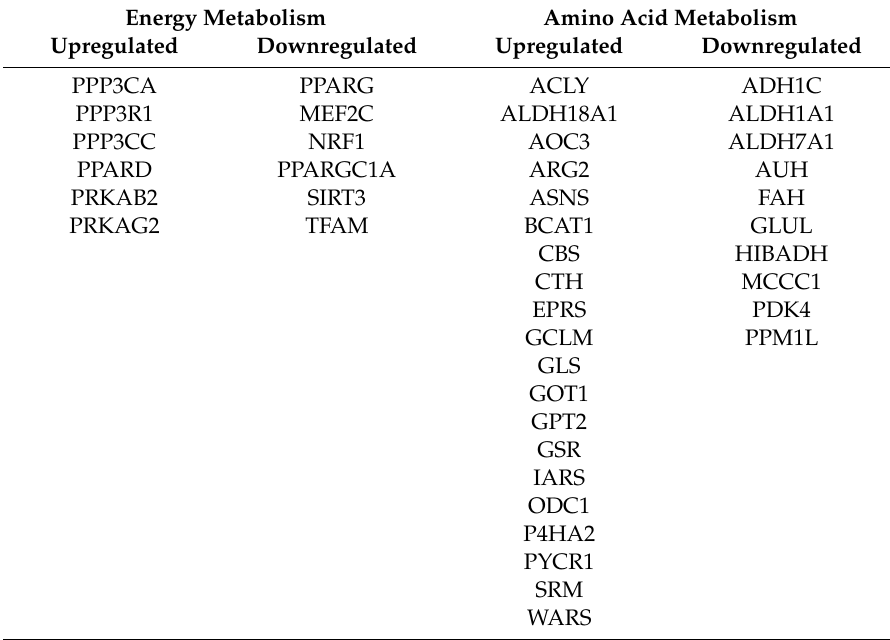
Figure 6. Di ff erentially expressed genes of the energy metabolism and amino acid metabolism after TGF-ß1 exposure. Energy metabolism and amino acid metabolism with the significantly di ff erentially expressed